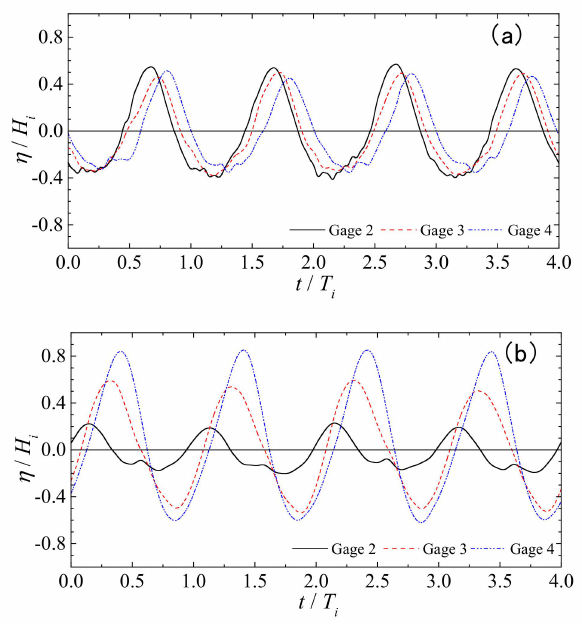
Figure 7. Recorded surface elevations in front of the breakwater–WEC (wave energy converter) system